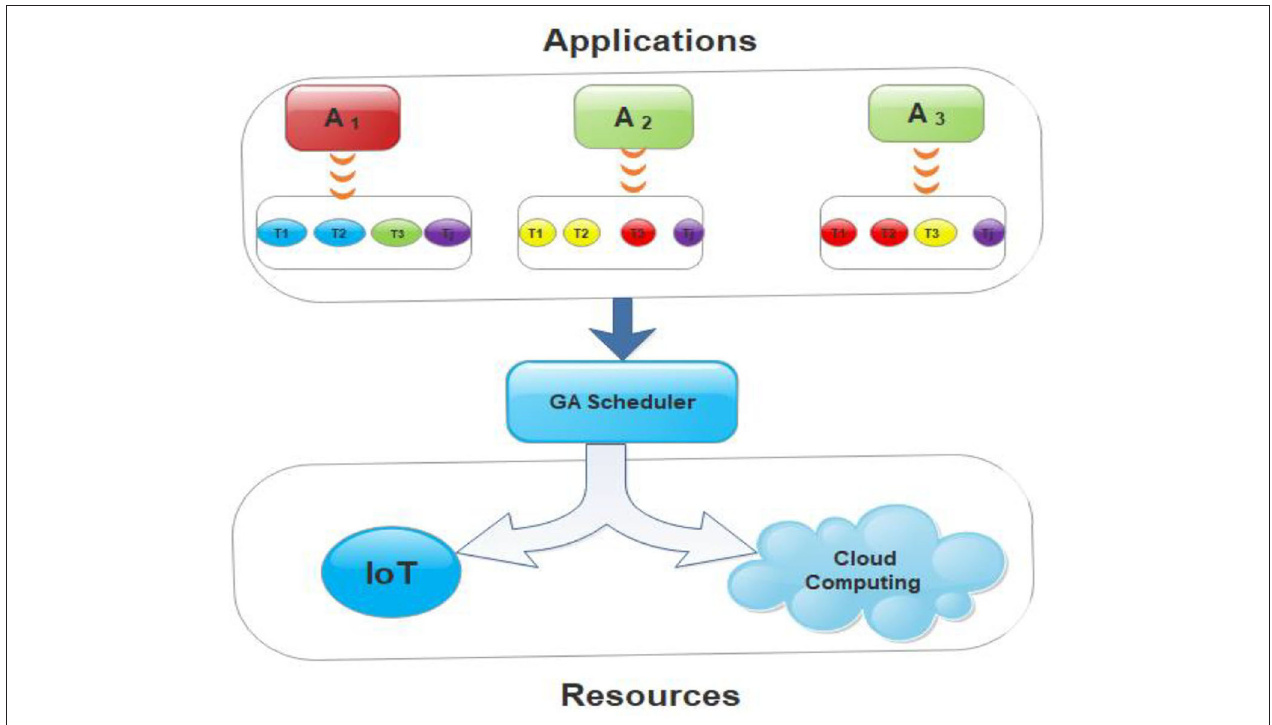
FIGURE 3 | Proposed optimizing energy consumption for Cloud IoT model.